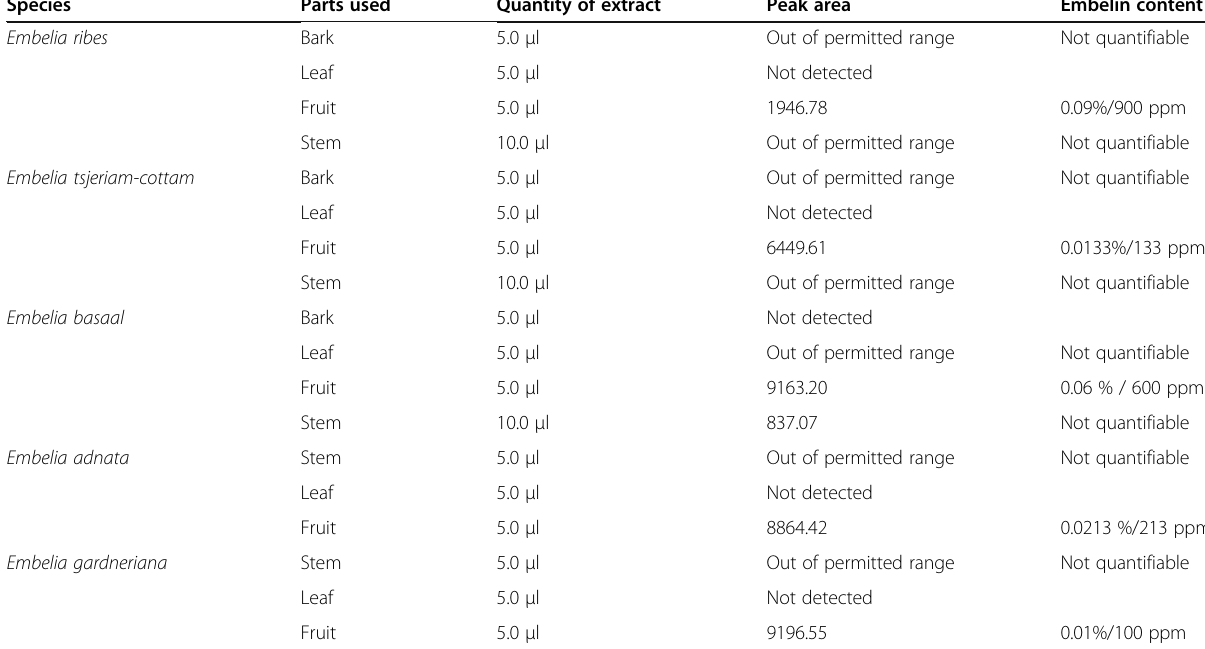
Table 3 Estimation of embelin in different Embelia species